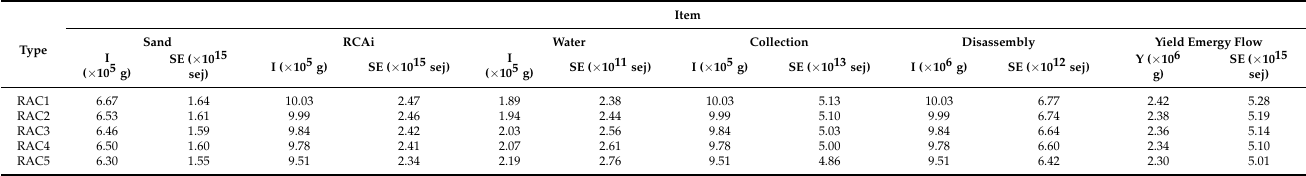
Table 7. Emergy evaluation form for different items of RACi.